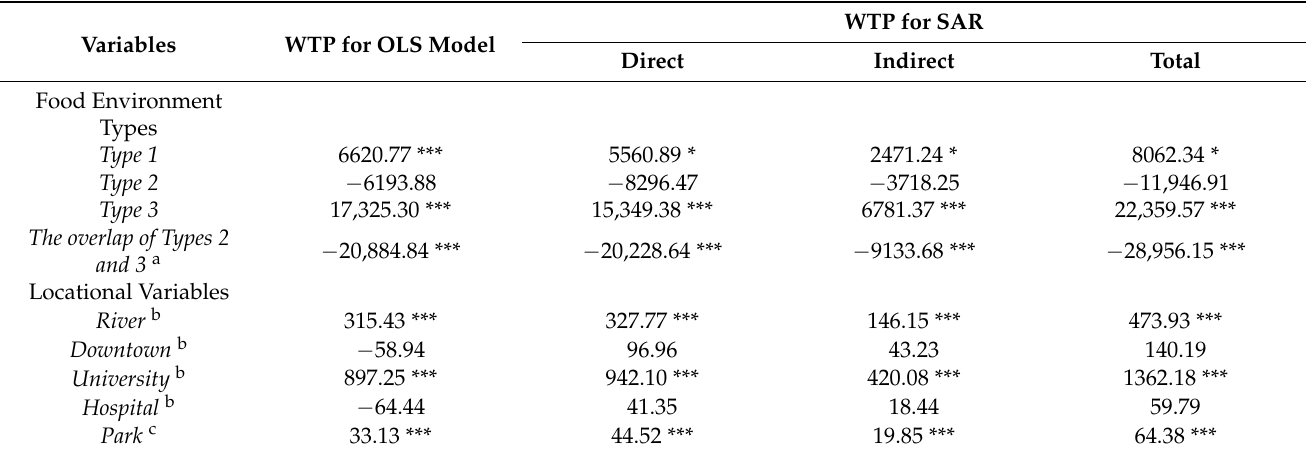
Table 5. The WTP for Spatial Lag Model Based on Nearest 10